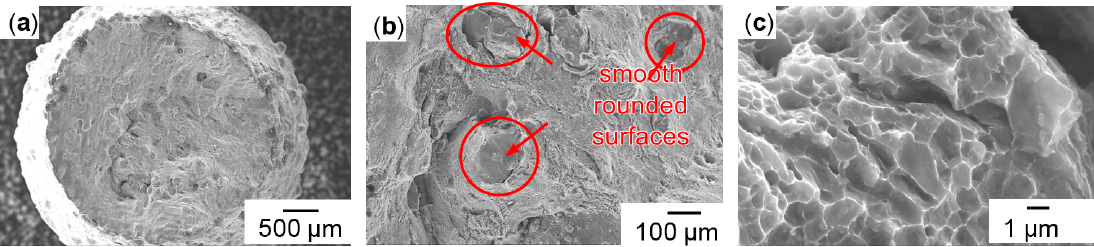
Figure 8. Vertical non-heat-treated ( a ) overview; ( b ) rounded surfaces; ( c ) fibrous structures.